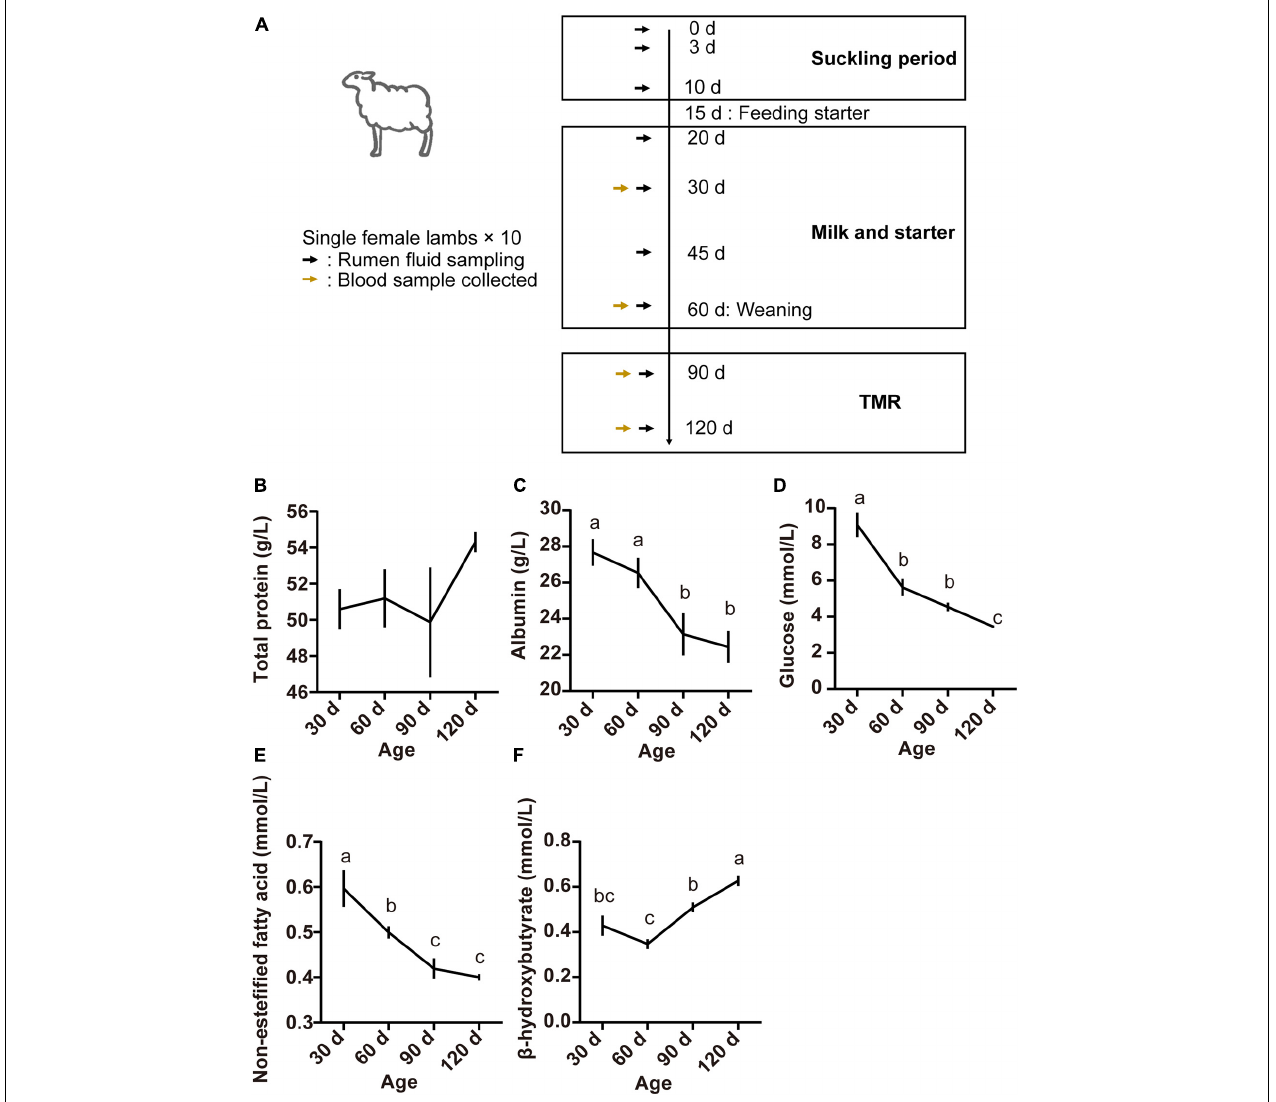
FIGURE 1 | Experimental design and sampling schedule of lambs (A) , serum concentrations of total protein (B) , albumin (C) , glucose (D) , non-esterified fatty acids (E) , and beta-hydroxybutyric acid (F) at different lamb ages. Data are expressed as mean ± SEM. a , b Letters denote significant differences between groups; groups that do not share the same letter are significantly different from each other ( P <